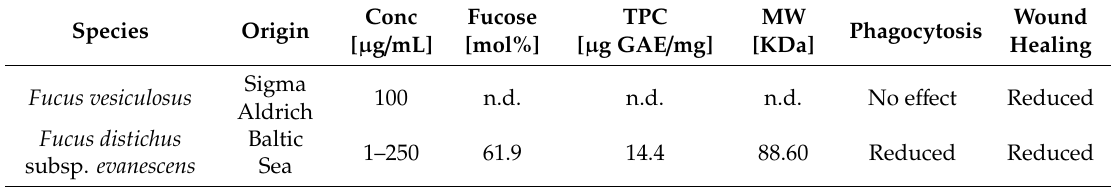
Table 4. List of tested fucoidans, retinal pigment epithelium (RPE)